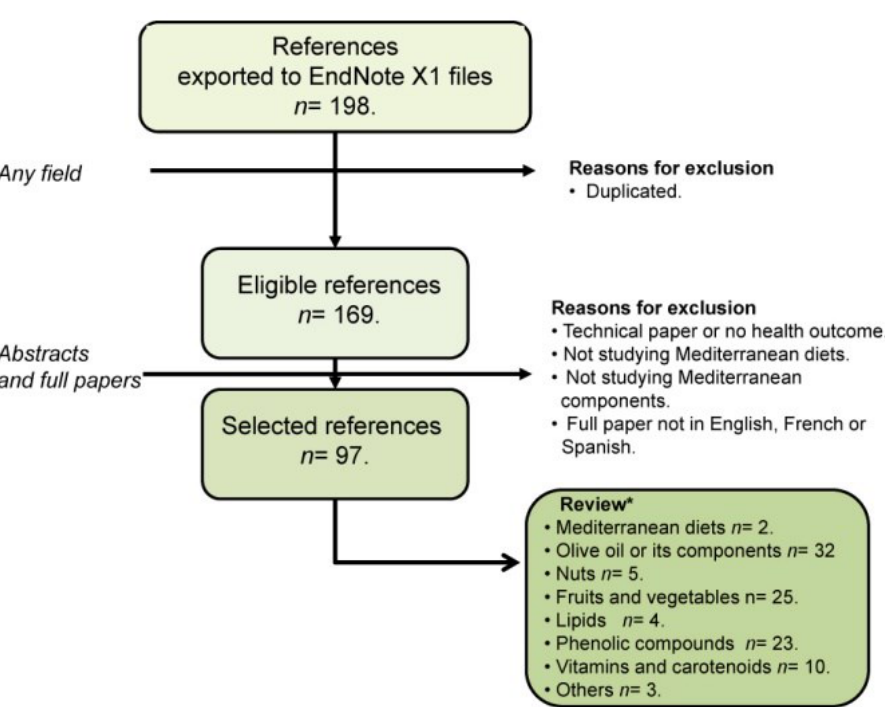
Figure 3. Flow chart displaying the stages used to select the references considered. EndNote X1 (Bld 2566, Thomson Reuters: New York, NY, USA, 2007). * Some references